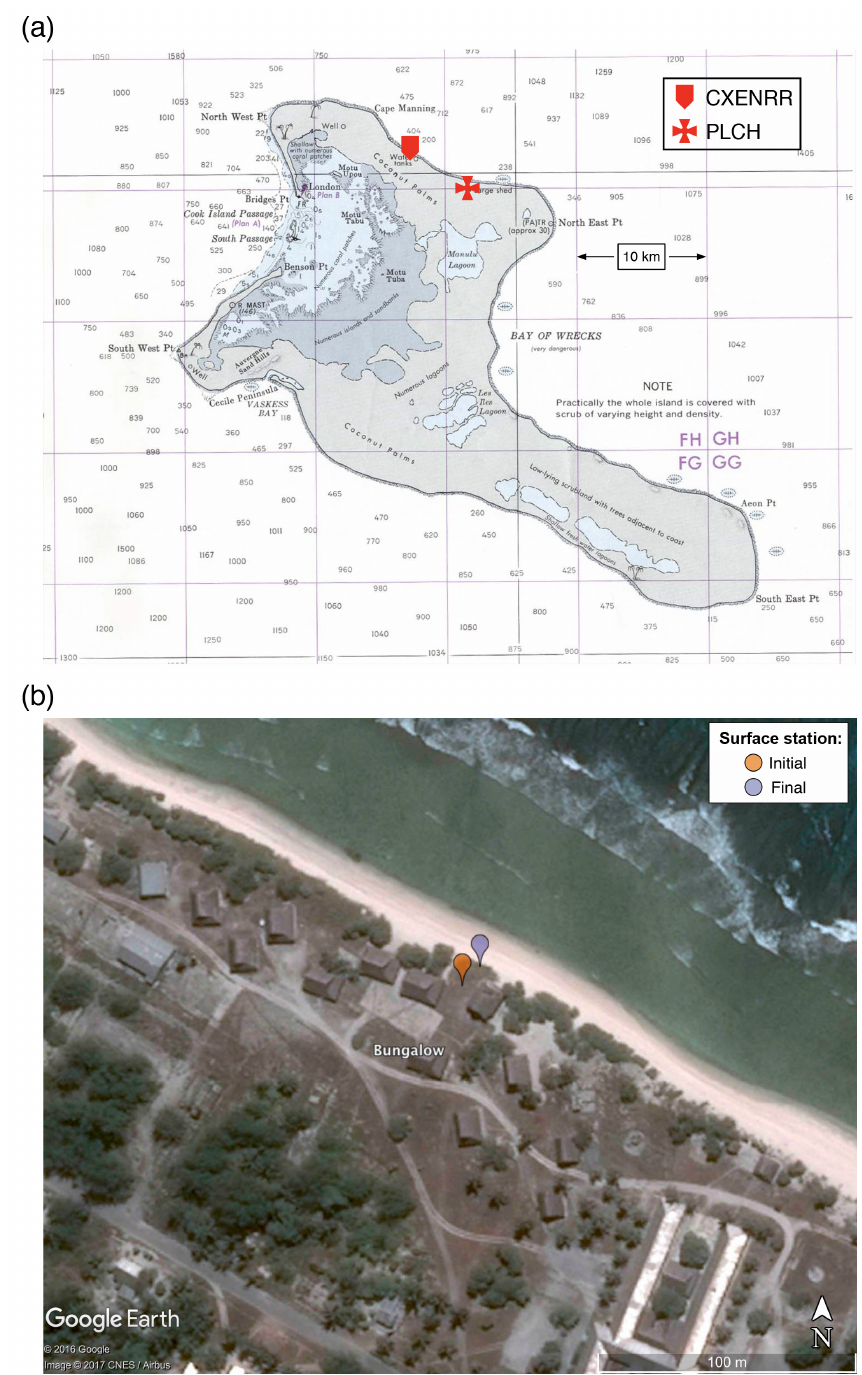
Figure 1. (a) Map of Kiritimati showing the locations of Cassidy International Airport (PLCH) and CXENRR. Kiritimati map excerpted from U.S. Defense Mapping Agency (DMA) Stock No. 83BHA83130, courtesy of the University of Texas Libraries, The University of Texas at Austin. Map data from surveys by New Zealand (1938–1941) and the U.S. Navy (to 1962). Heights are in feet above mean high water springs; soundings are in fathoms (or fathoms and feet if less than 11 fathoms). (b) Detail of the CXENRR site at the Captain Cook Hotel. The bungalow which served as our base of operations is in the center of the image, with markers to its north indicating the initial and final locations of the surface meteorological